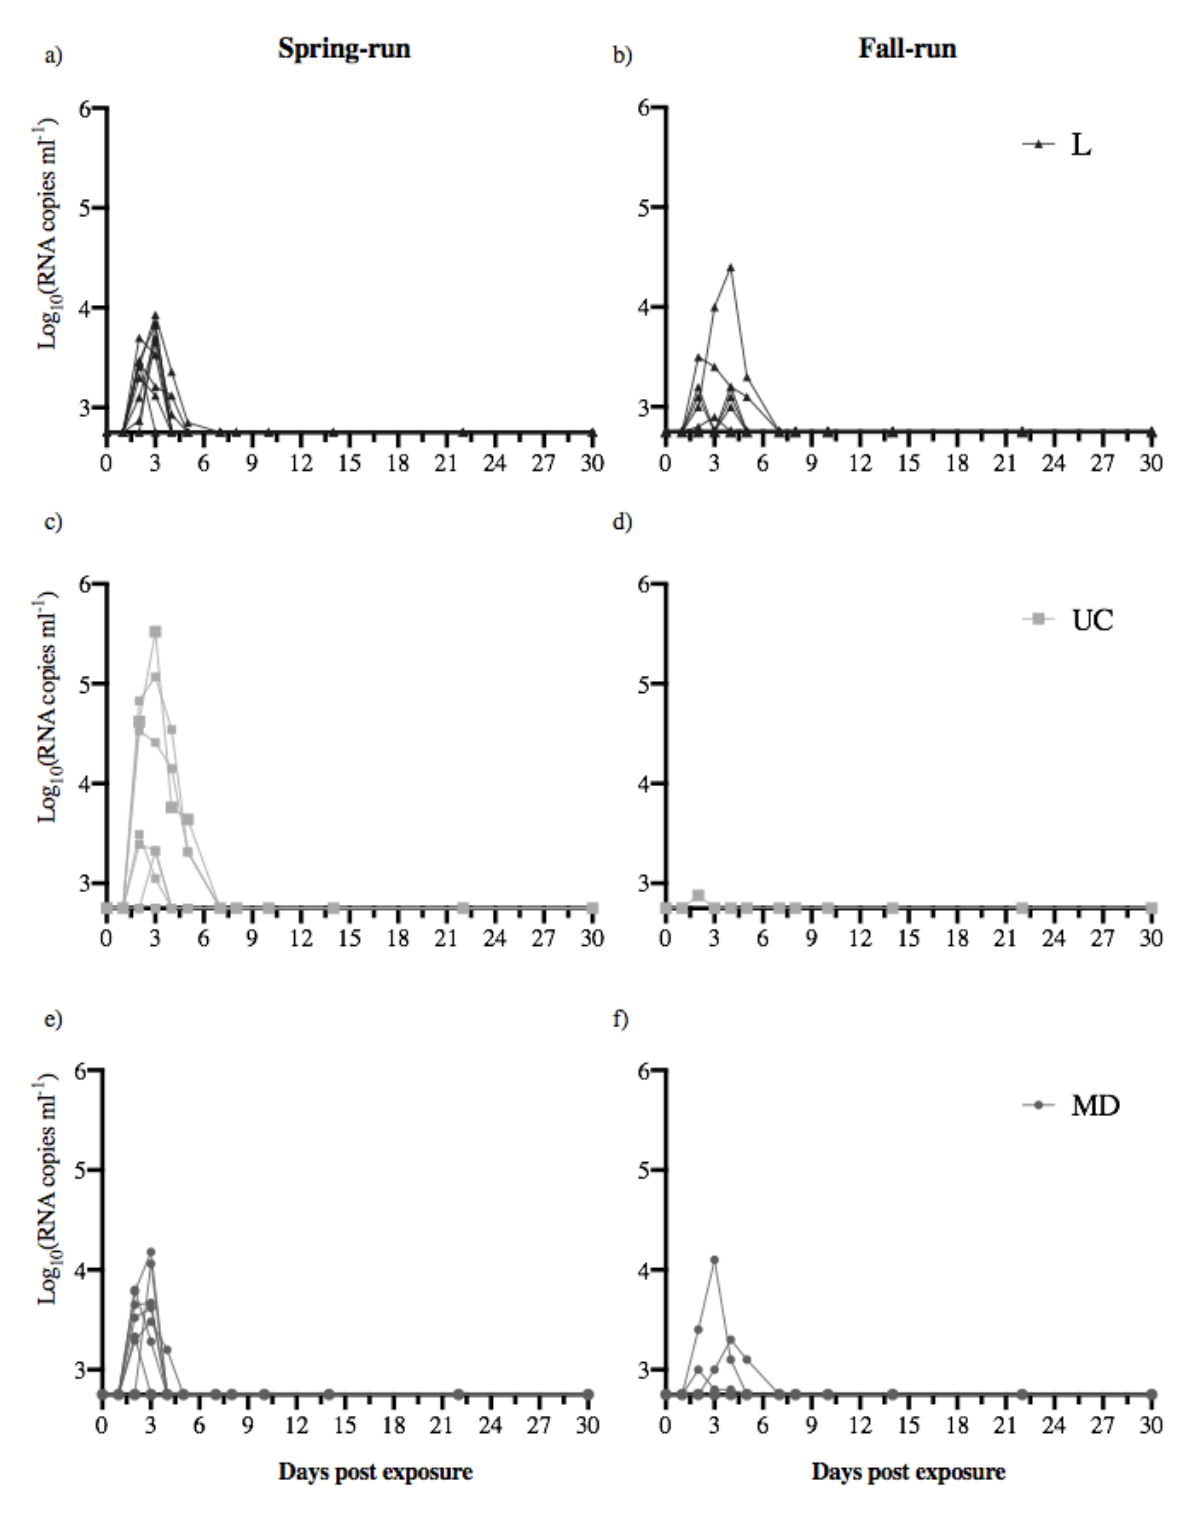
Figure 2. Daily quantity of virus shed by individual fish. Each panel shows the shedding kinetics of individual fish over the 30-day course of infection. Daily quantities of L ( a , b ), UC ( c , d ) and MD virus ( e , f ) shed from spring- ( left ) and fall-run Chinook salmon ( right ) are reported as log 10 virus RNA copies mL − 1 . The detection limit of the universal N gene IHNV reverse transcriptase real-time PCR (RT-rPCR) assay (2.75 log 10 RNA copies mL − 1 ) is reflected as the base of the y -axes. No fish in the virus-free treatment (negative control) shed detectable